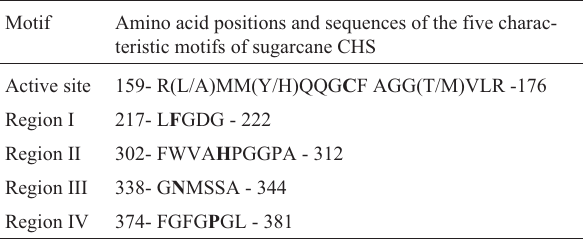
different regions correspond to the loops of the secondary structure of the